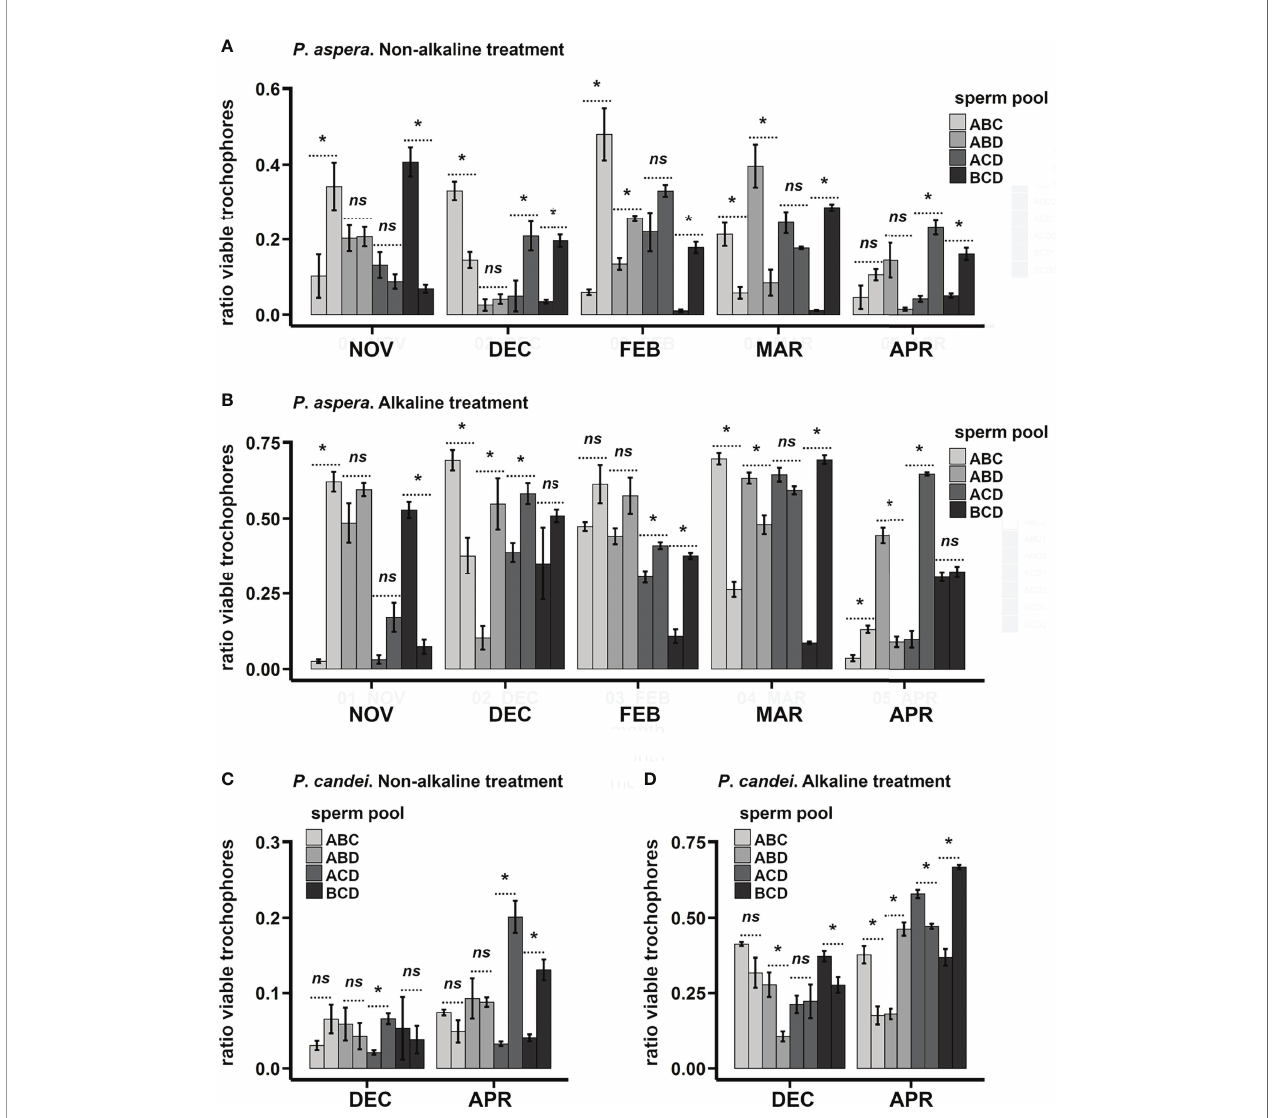
FIGURE 6 | Individual variation of the fertility among female limpets, studied as a ratio of viable trochophores, and comparison between non-alkaline (control) and alkaline treatments. Eight females were analyzed each month. Each bar represents the average ± SD ratio of viable trochophores obtained in each female. The females of each species follow the same order in non-alkaline and alkaline treatments. The differences in ratio of viable trochophores within pairs of females fertilized using the same sperm pool were analyzed statistically (n.s., not signi fi cant differences; * p < 0.01). Ratio of viable trochophores in different females of P . aspera (A, B) : non-alkaline treatment (A) and alkaline treatment (B) . Ratio of viable trochophores in different females of P . candei (C, D) : non-alkaline treatment (C) and alkaline treatment (D)